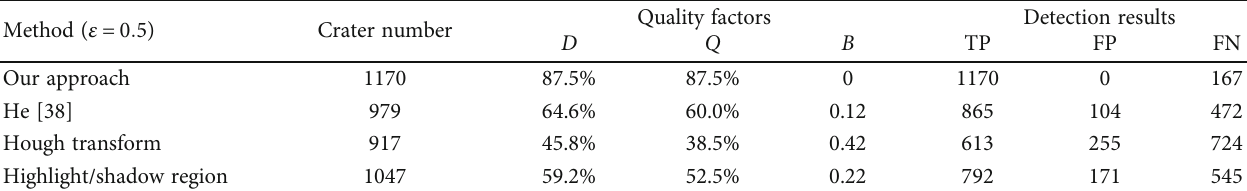
Table 7: Comparison with other crater detection algorithms.